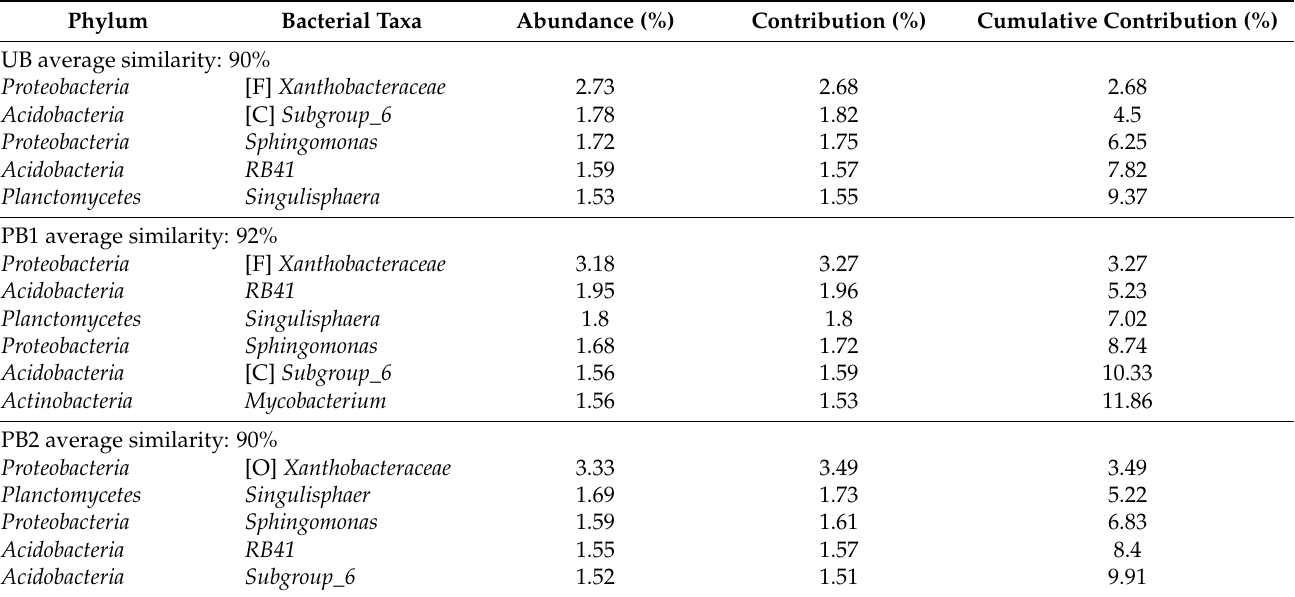
Table 4. SIMPER shows the relative abundance of the contribution of bacterial phyla and taxa with the lowest level of classification, the total and cumulative contribution to the average similarity as a percentage. Degree of similarity for each treatment. Contributions of bacterial taxa to mean percent similarity less than 1.5% are not